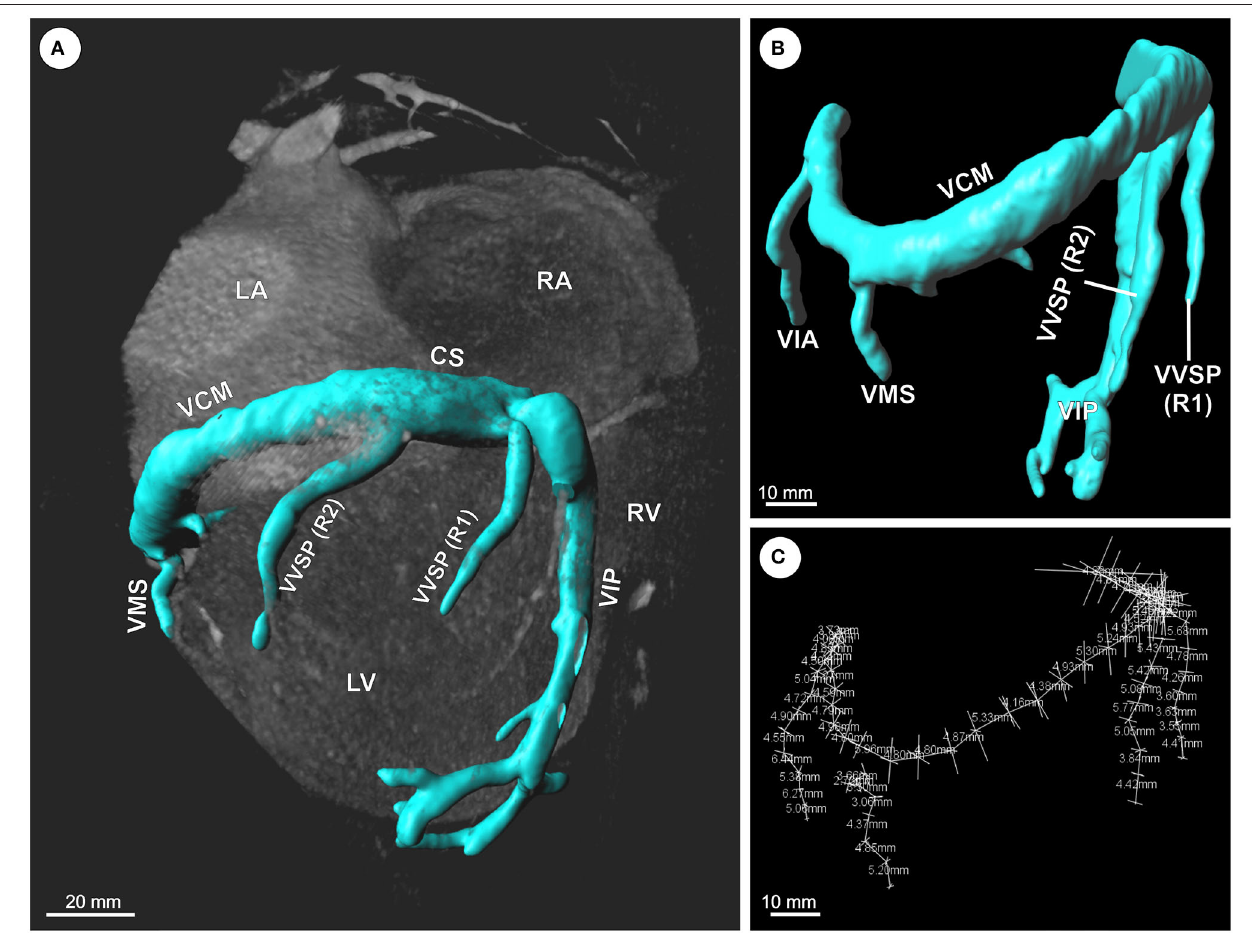
FIGURE 2 | (A–C) Exemplary 3D reconstruction and morphometric analysis of the coronary vein system (CVS) based on CT datasets. (A) Volume rendered CT image of the heart with overlaid surface model of the CVS. (B) Reconstructed surface model of the CVS with overlaid orthogonal measurements every 5mm. (C) Measurement points and lines along the CVS. CS, coronary sinus; LA, left atrium; LV, left ventricle; RA, right atrium; R1/R2, 1st/2nd ramus; RV, right ventricle; VCM, great cardiac vein; VIA, anterior interventricular vein; VIP, posterior interventricular vein ( = middle cardiac vein); VMS, left marginal vein; VVSP, left posterior ventricular